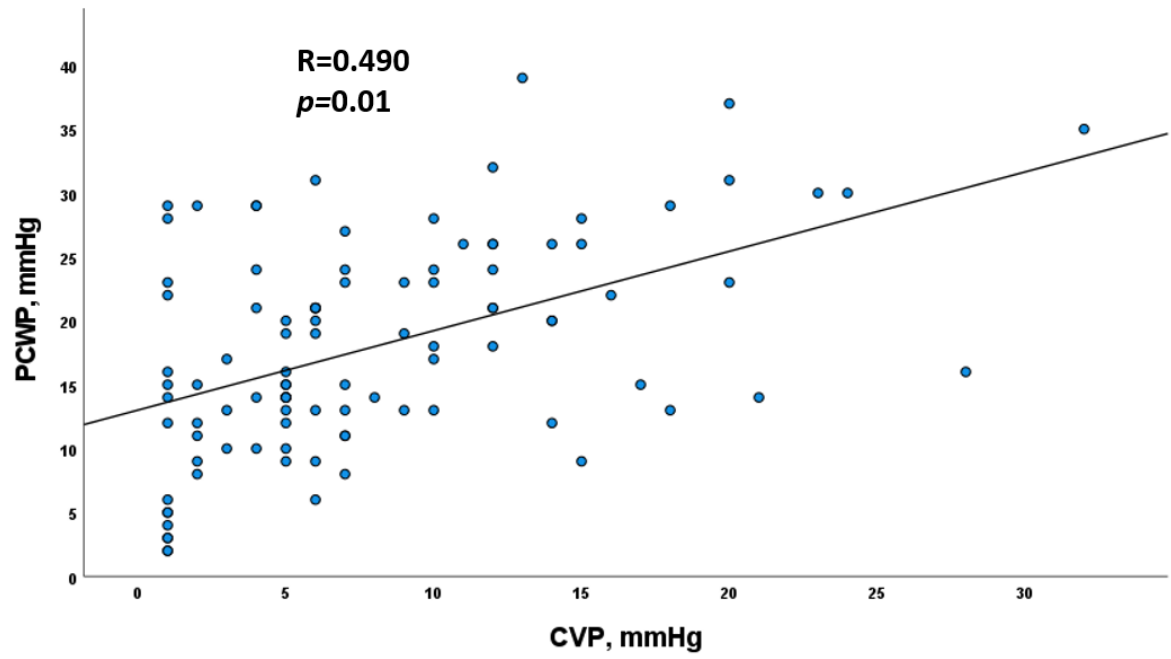
Figure 3. Linear correlation graph between PCWP and CVP from Pearson test. CVP, central veinous pressure; PCWP, pulmonary capillary wedge pressure.